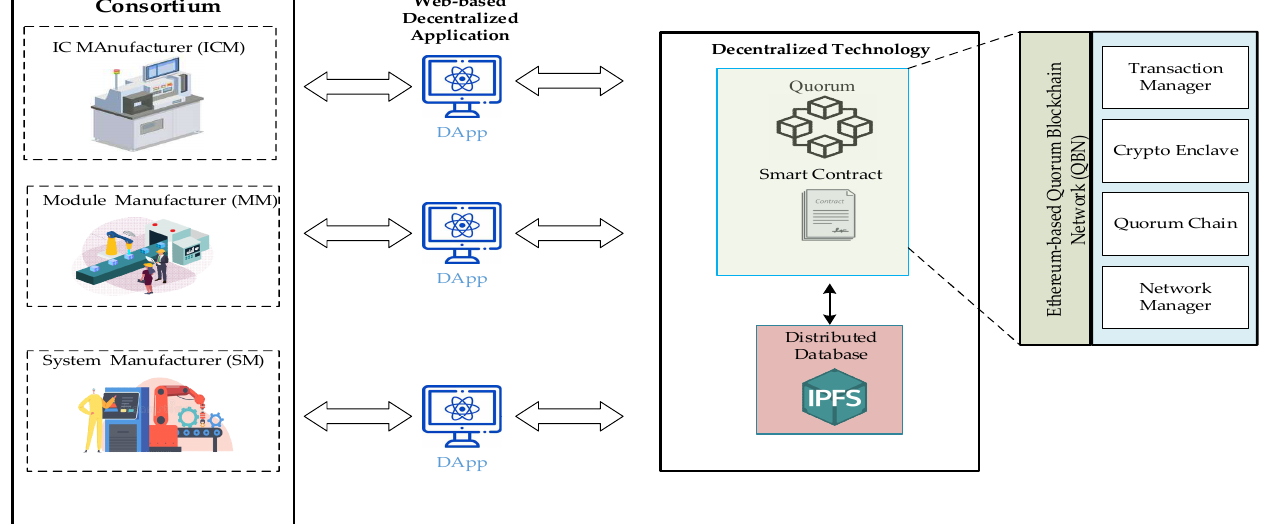
Figure 1. The proposed framework including Quorum blockchain, distributed database (IPFS), and DApp.